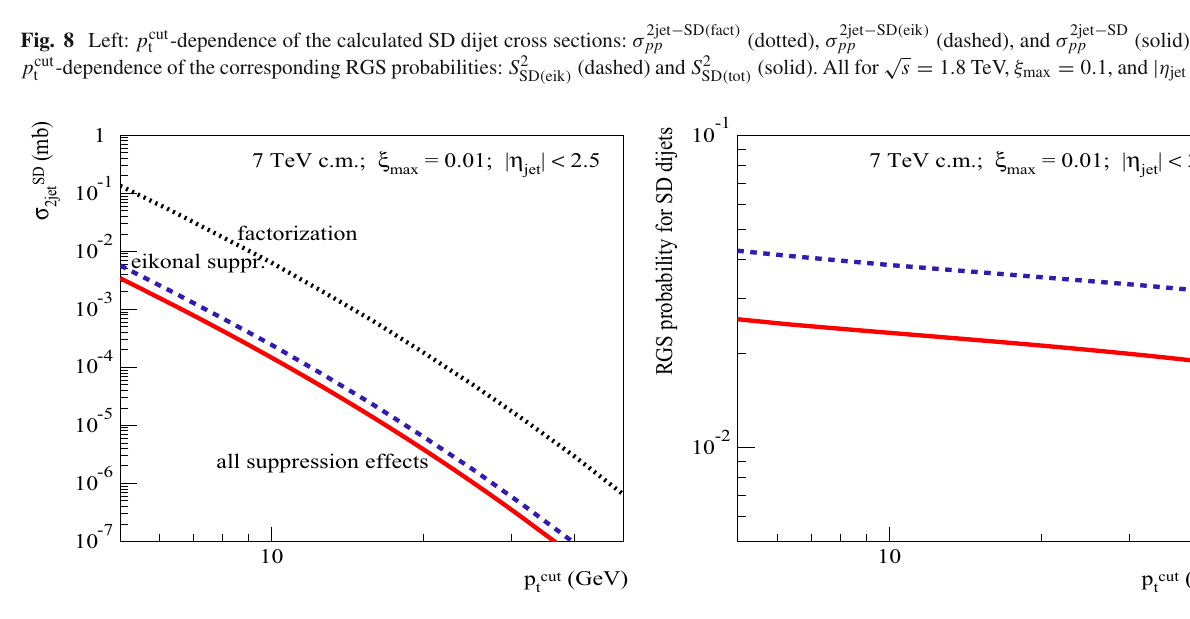
Fig. 9 Same as in Fig. 8 for